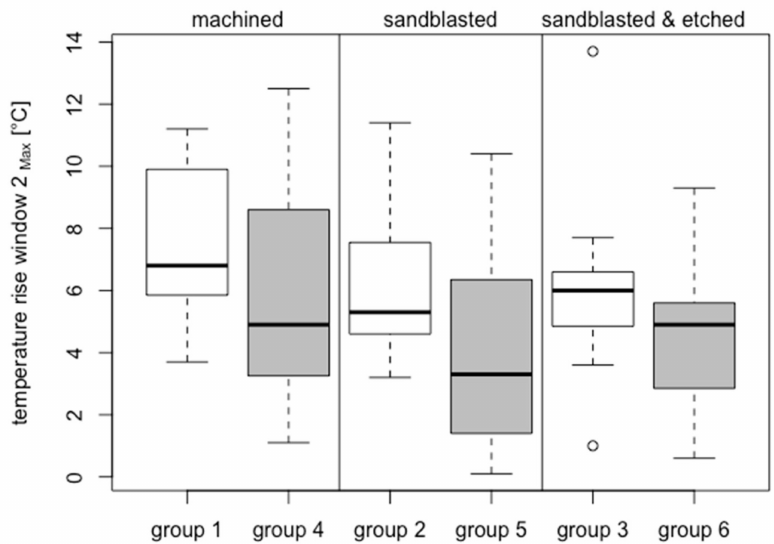
Figure 8. Box plots showing rise of temperature at bone window 2—results of all 6